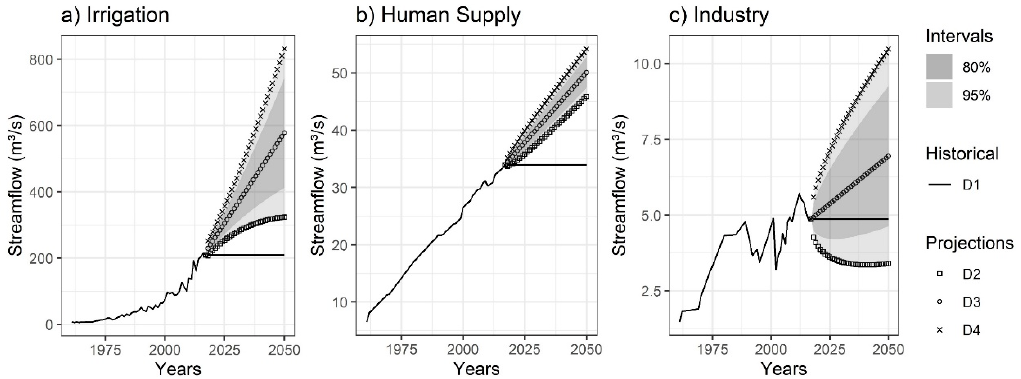
Figure 11. Scenarios of the projections of annual consumptive demands on the Sobradinho reservoir using the exponential smoothing (ETS) model for the period 2018 to 2050.